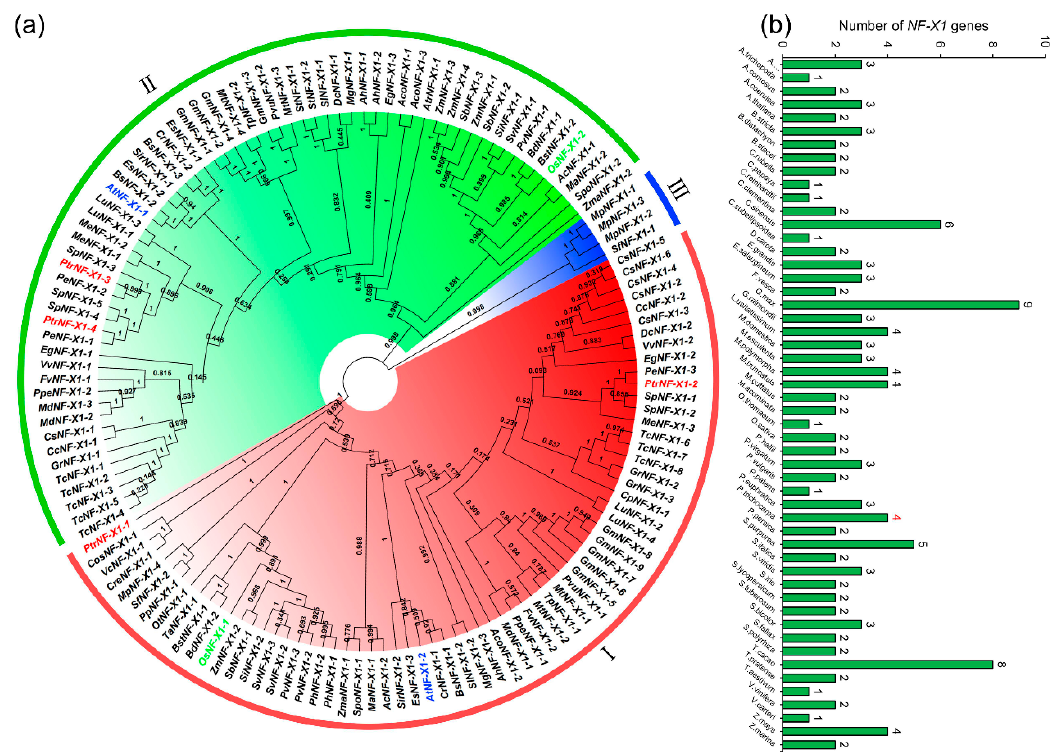
Figure 1. Evolutionary and phylogenetic analysis of the NF-X1 family in diverse plant species. ( a ) The phylogenetic tree of NF-X1 proteins in 52 plant species. The arcs of different colors and I, II, III represent different classes of NF-X1 domains. The red, green and blue characters represent the NF-X1 domains from poplar, rice and Arabidopsis, respectively. ( b ) Comparisons of NF-X1 proteins number across 52 species of plant.